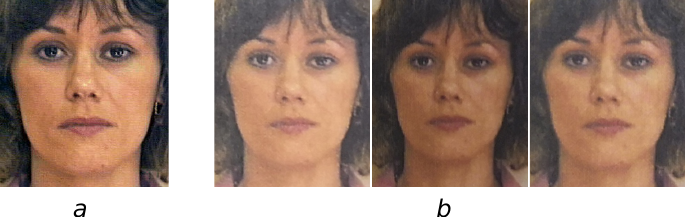
Figure 4. Example images from the Print-Capture Aberdeen dataset: ( a ) original digital image; and ( b ) captured photo image.